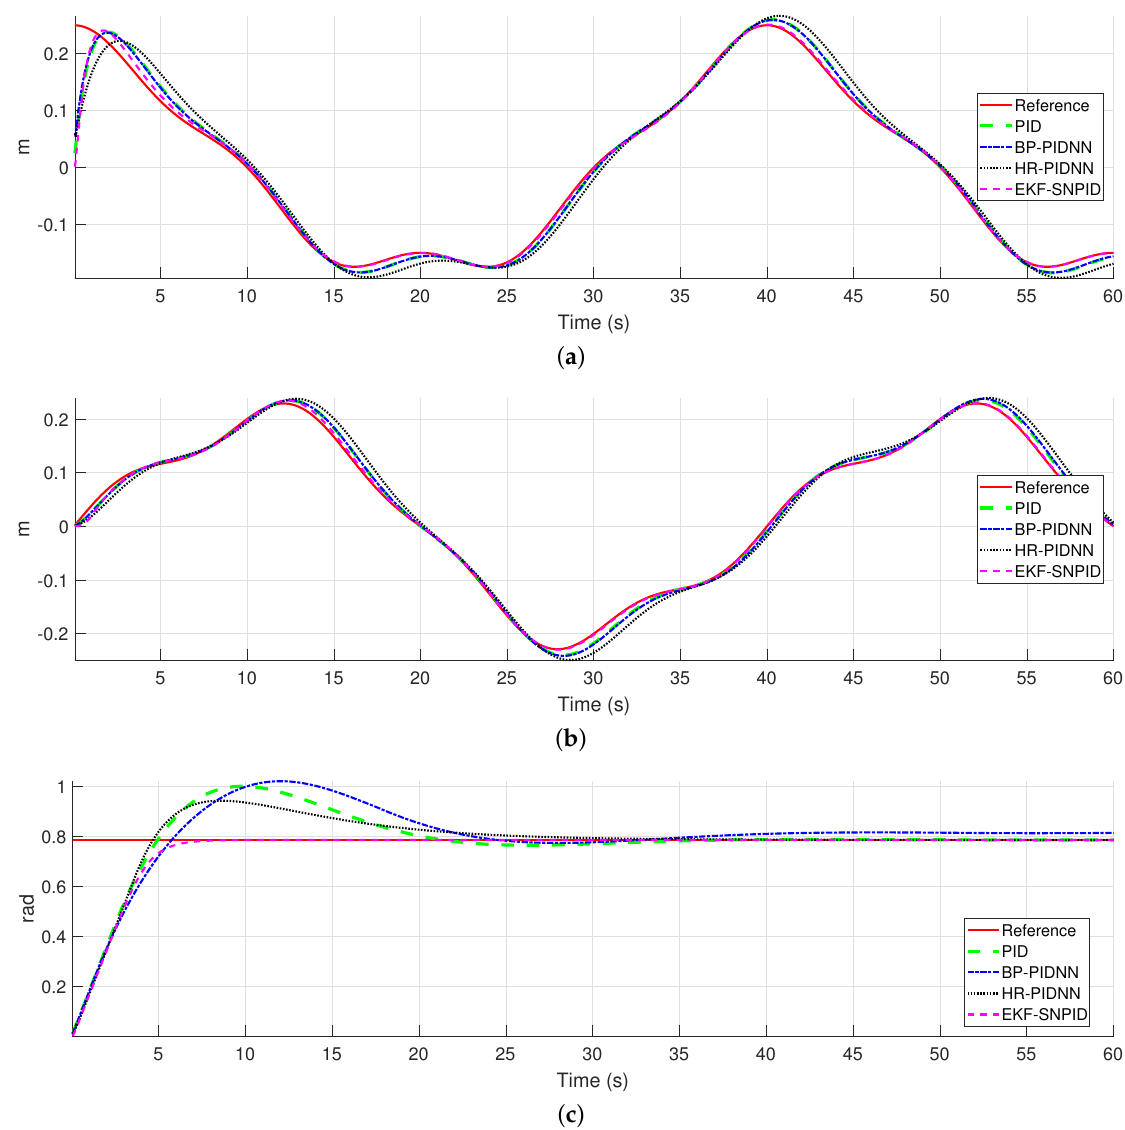
Figure 14. System response for the rose curve trajectory. BP-PIDNN: Neural PID controller trained with Back Propagation algorithm. HR-PIDNN: Neuron PID controller trained with Hebbian learning